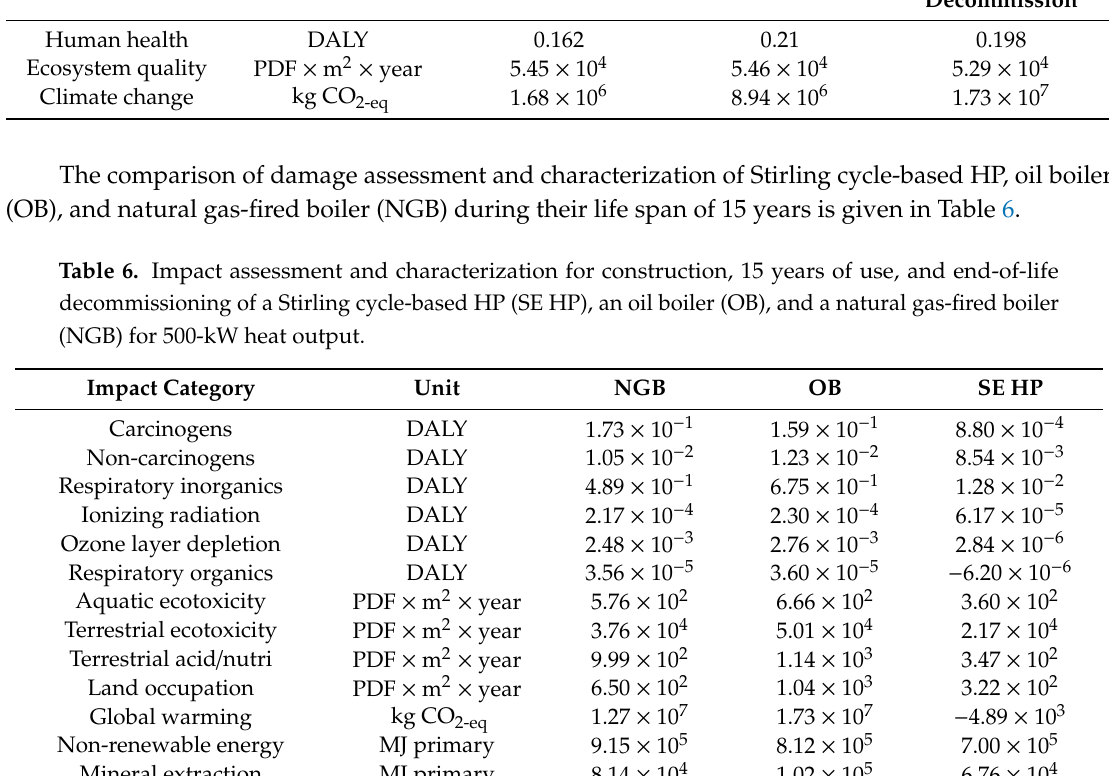
Table 5. Impact assessment and characterization for oil boiler (OB).